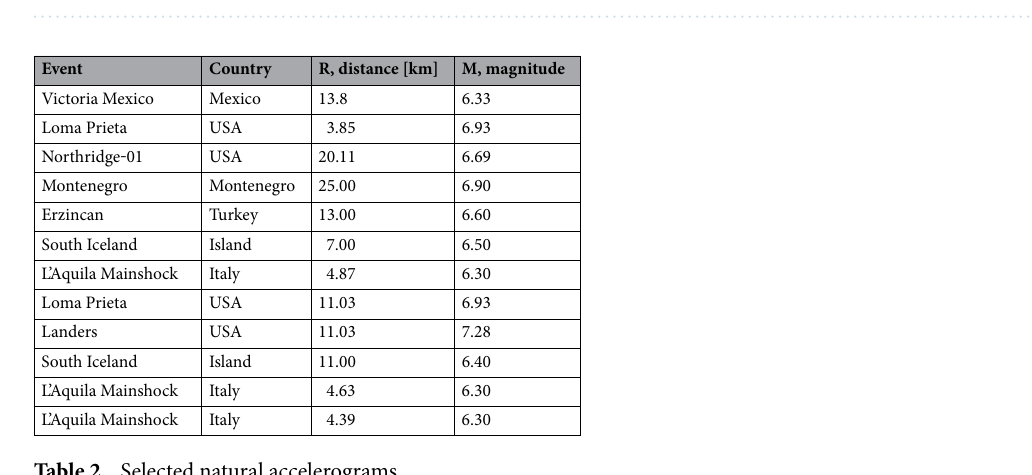
Figure 5. ( a ) Typical hysteretic loop of a Bouc–Wen model; ( b ) comparison between experimental and numerical responses after Paolacci and Giannini 9 .